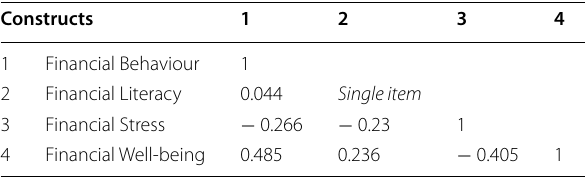
Table 4 Latent variable correlations